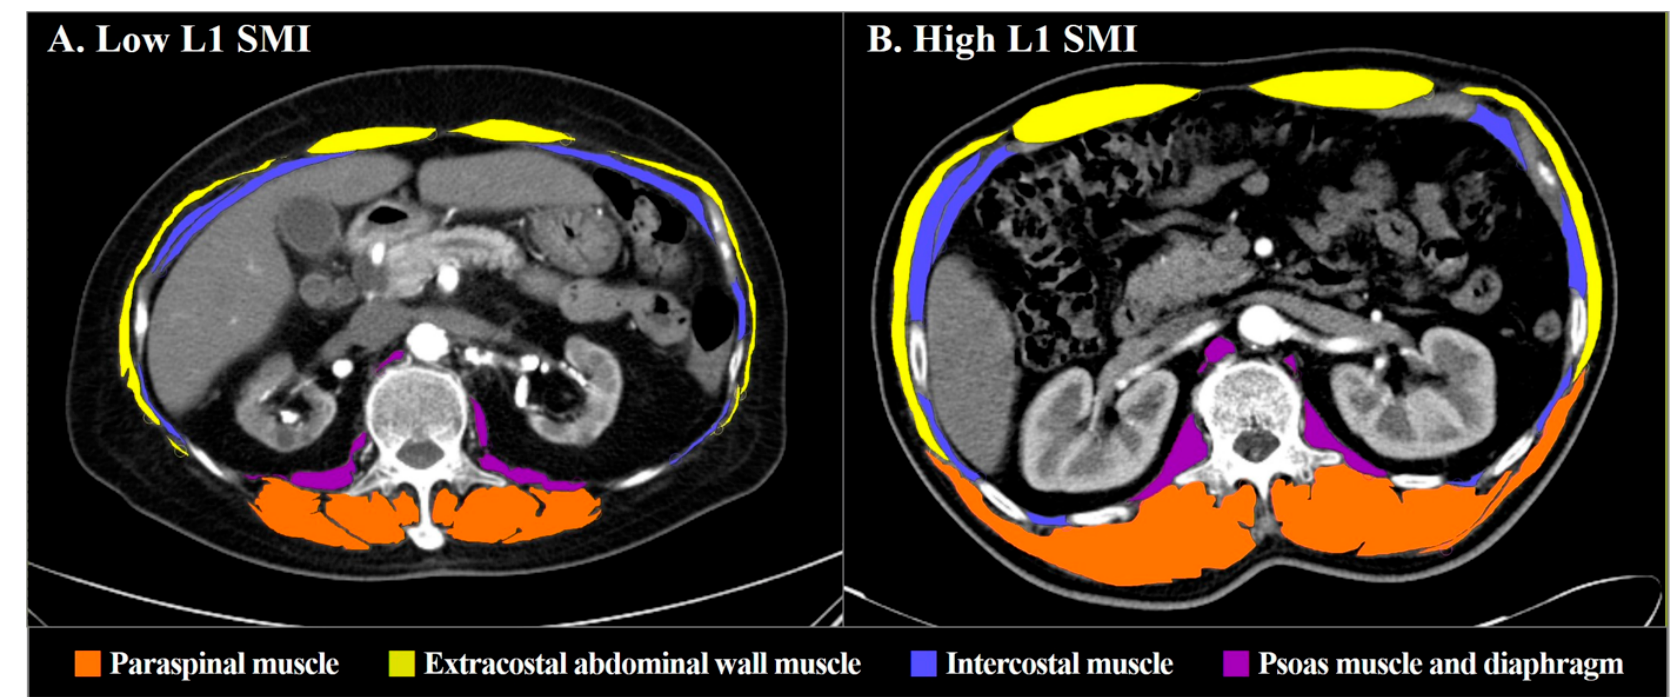
Figure 1. Representative CT images of L1 skeletal muscle area measurement: A patient with low L1 SMI ( A ) and a patient with high L1 SMI ( B ). Total skeletal muscle area was measured using the following four components: Paraspinal muscle (red), extracostal abdominal wall muscle (yellow), intercostal muscle (blue), and psoas muscle and diaphragm (purple). The measured L1 SMAs were 36.24 ( A ) and 149.56 cm 2 ( B ), and L1 SMIs were 16.00 ( A ) and 49.68 cm 2 /m 2 ( B ), respectively. CT = computed tomography; L1 = first lumbar vertebra; SMA = skeletal muscle area; SMI = skeletal muscle index.